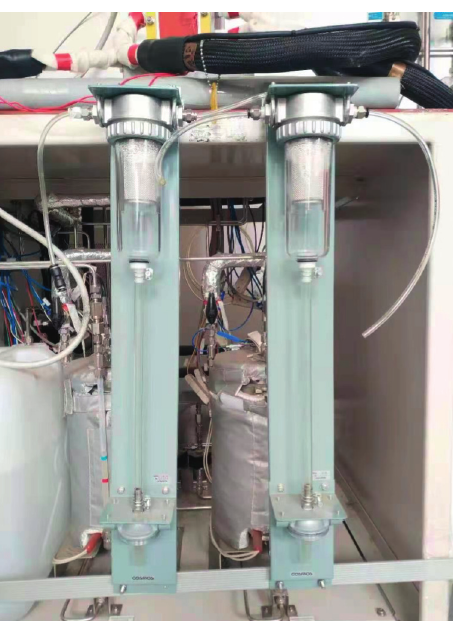
Figure 2: Structure of the water recover devices for the fuel